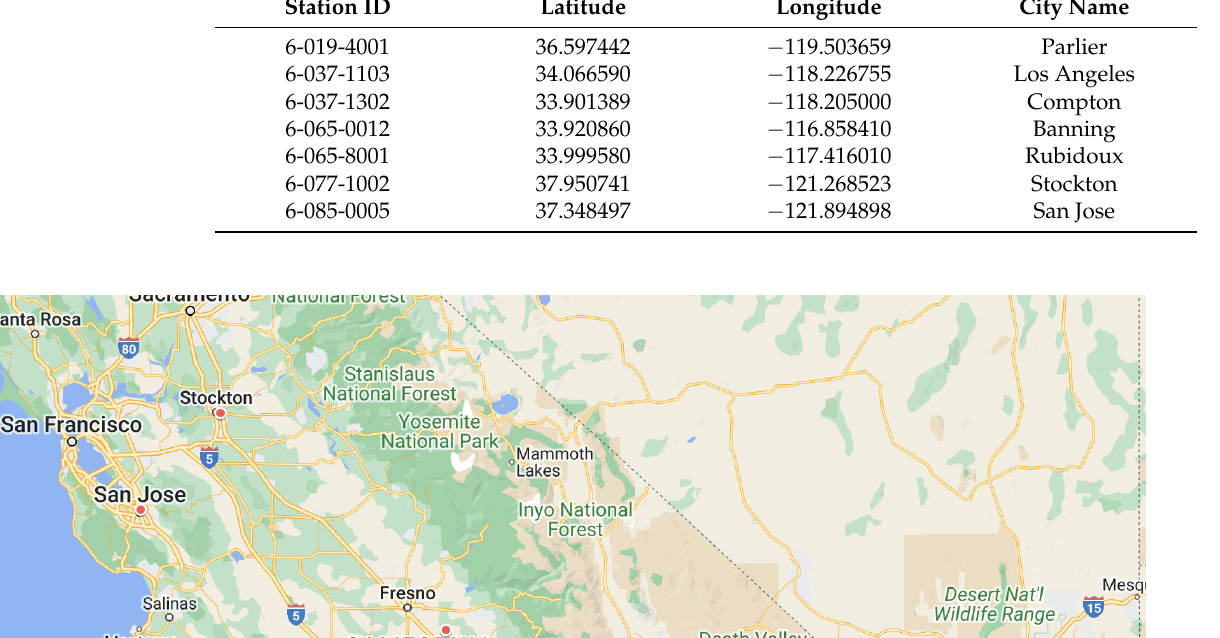
Table 1. Information (latitude, longitude, and location name) of the considered ozone monitoring stations. Station ID